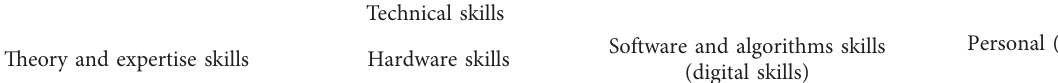
Table 3: Required skills of industry